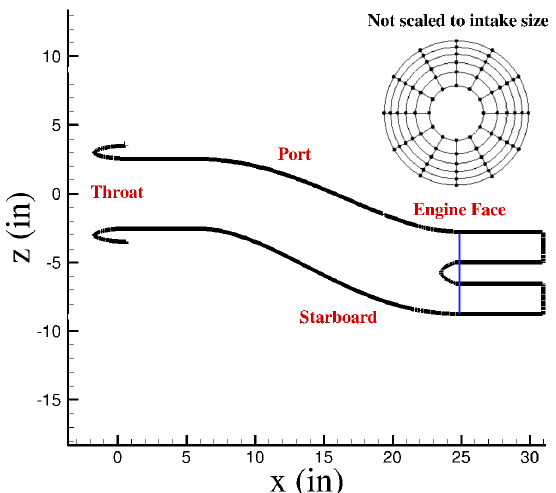
Figure 1. The sketch of the RAE M2129 geometry used in this work. The pressure rakes at the engine face are shown as well. They include 12 equally spaced arms with 30-degree intervals with six pitot pressure probes at each